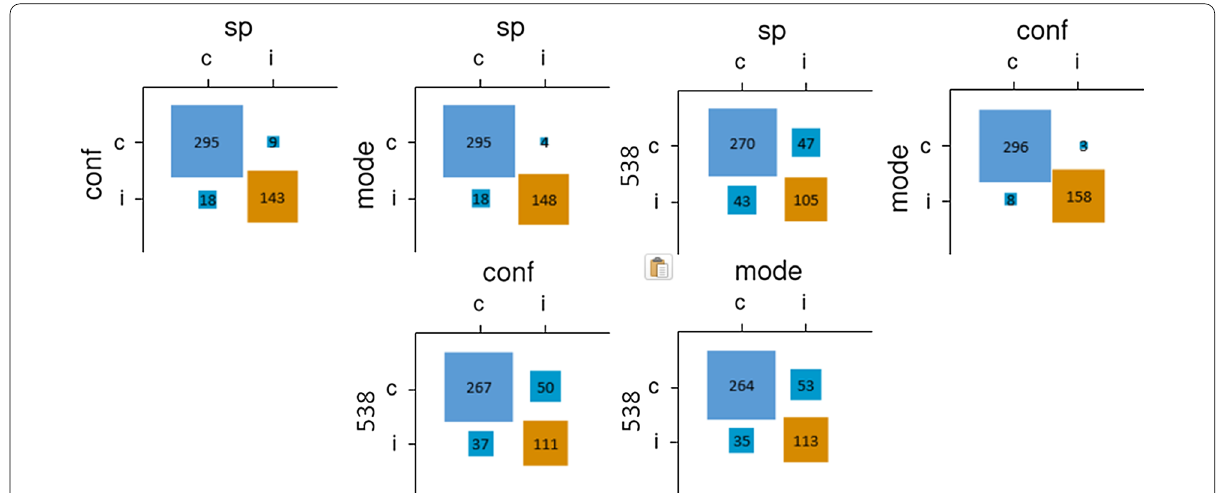
Figure 6 Relationships between pairs of prediction methods for Study 3 (total sample). Note sp conf confidence-weighted; mode =